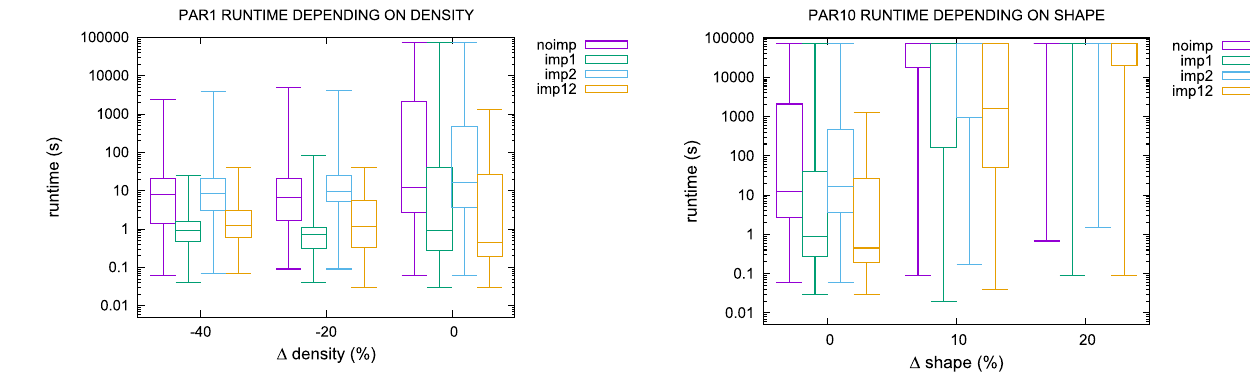
Fig. 4 PAR10 (in seconds) of solving real-world B2B instances, with and without using implied constraints, varying their shape s , and with T ⋅ a fixed density, i.e., fixed